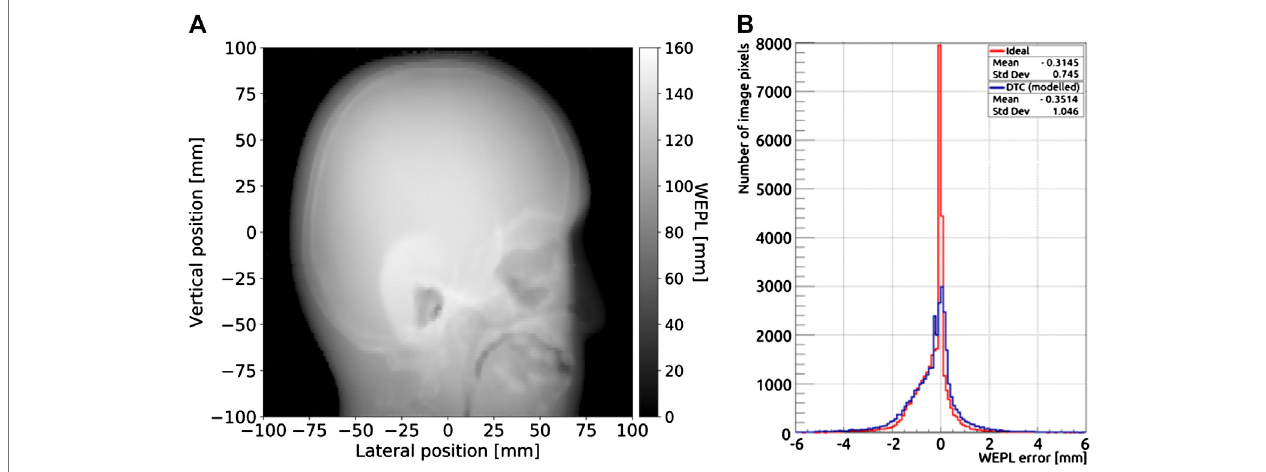
FIGURE13|(A) AThesimulatedCTP404 phantomreconstructedwithafullpCTscanforthemodeledsetup. (B) Comparison ofthepercentage relative errors for each insert material in the CTP404 phantom for the ideal and modeled setups.